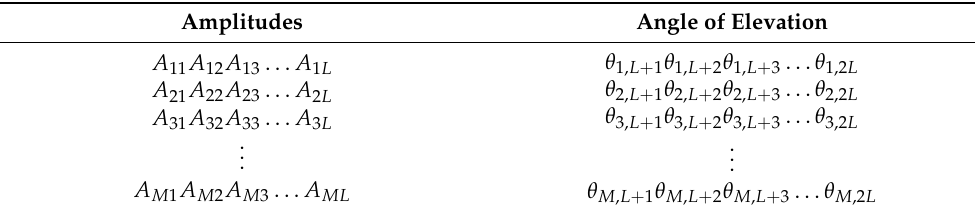
Table 2. Randomly generated